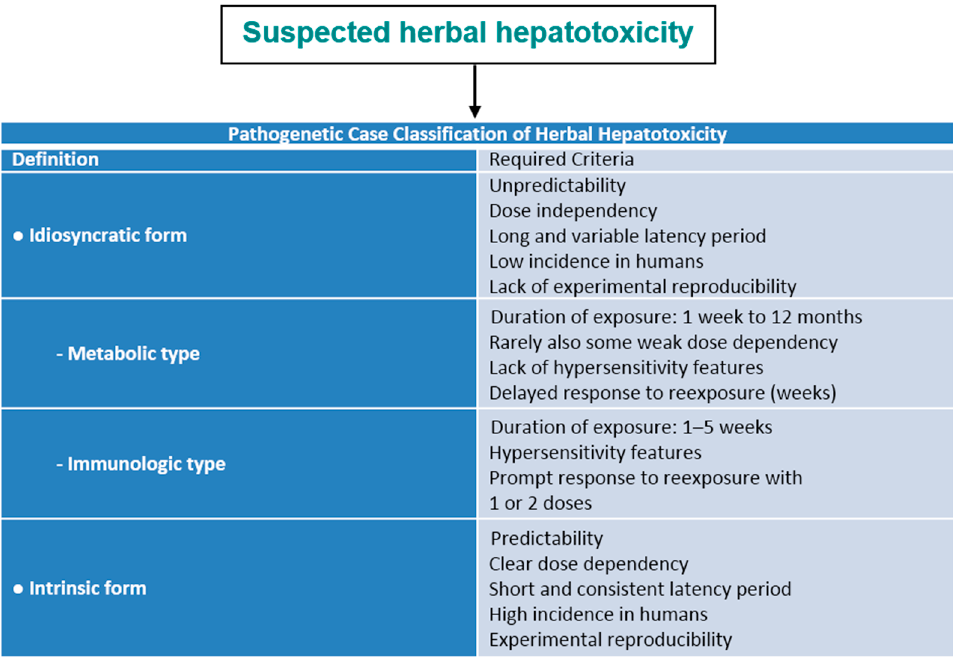
Figure 1. Pathogenetic classification of HILI. Data adapted from a previous report [8].